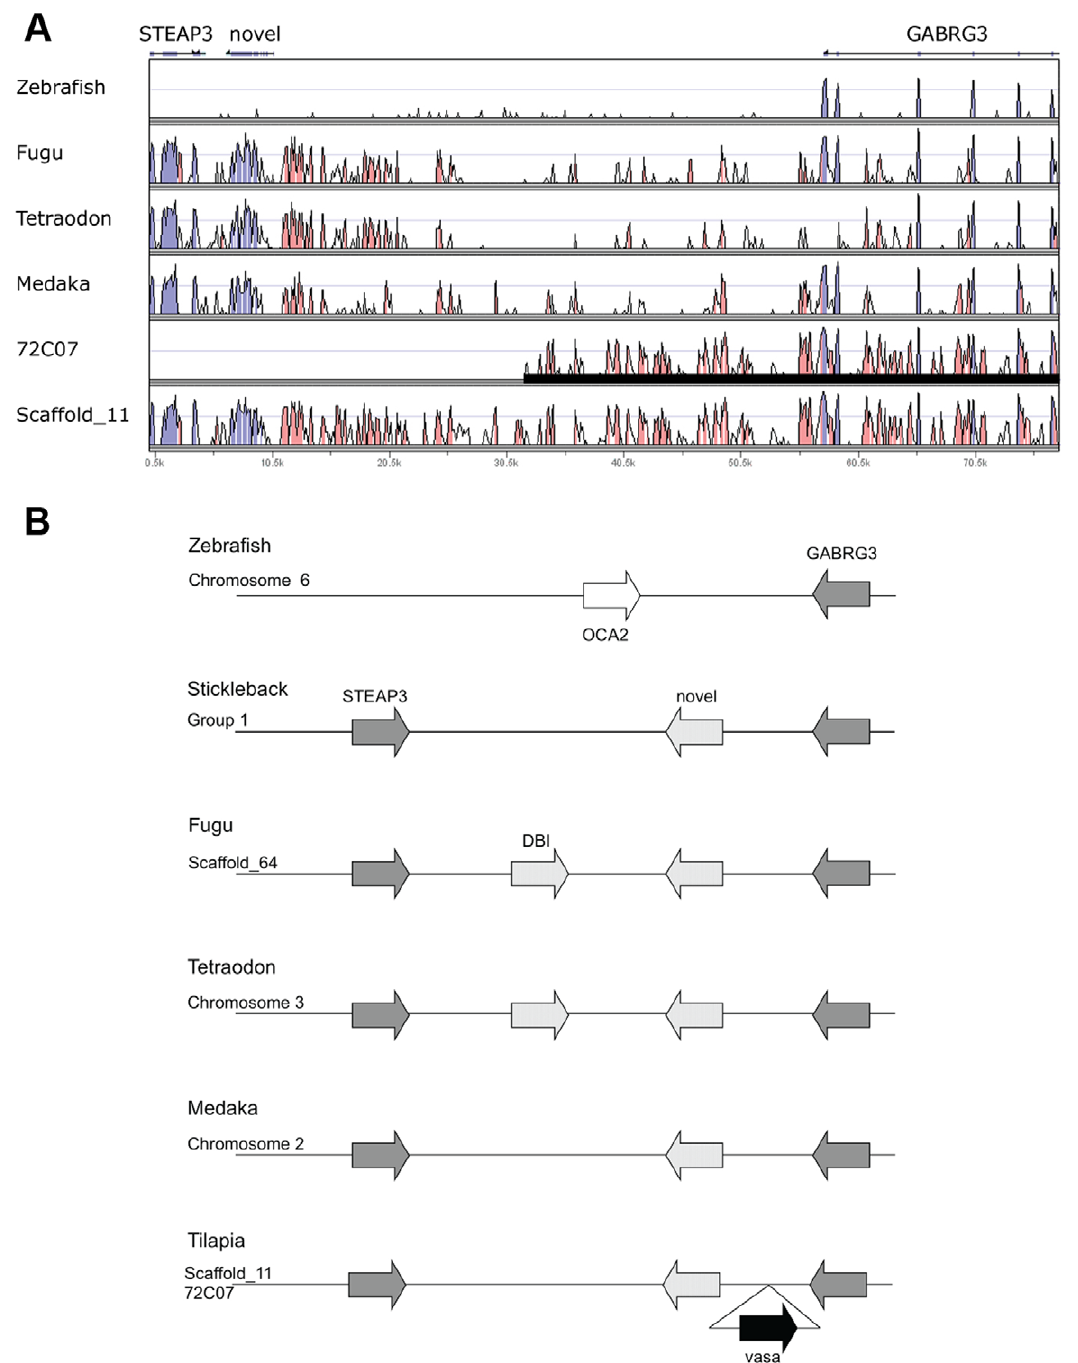
Figure 4. BAC clone 72C07 corresponds to a region between the STEAP3 and GABRG3 genes. (A) VISTA plots against stickleback show that 72C07 and Scaffold_11 correspond to a region between the STEAP3 and GABRG3 genes. Black bar indicates the region covered by BAC clone 72C07. Note that a vasa gene is not located in this region of other teleosts. (B) Genomic organization between the STEAP3 and GABRG3 genes of zebrafish, stickleback, fugu, Tetraodon , medaka and tilapia. The genomic organization is found conserved in other teleosts, except in the distantly related zebrafish and that the DBI gene is found to be lineage-specific. The vasa gene copy on 72C07 was inserted into the intergenic region between a novel gene and GABRG3. (e.g. zebrafish [33]). A dominant feature of fish genomes is the Further studies are needed to determine how the splicing isoforms are generated. [34], followed by lineage-specific gains and losses of individual genes [35]. Sequence polymorphisms in vasa likely arising from alternative splicing forms have been characterized in some species